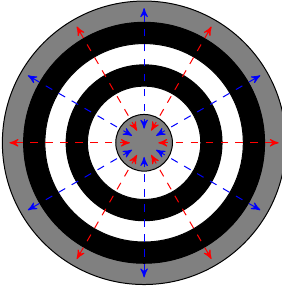
Figure 26 . Bulk e(cid:11)ective representation of connectivity in terms of the (cid:18) angle measuring the 3-cycles in the 5-sphere.